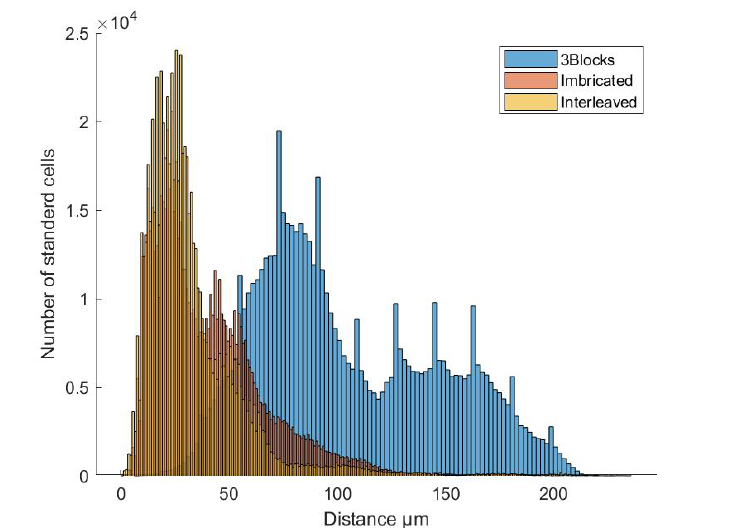
Figure 6. TMR branch logic spacing for the 8 × 16 bit design post-Clock Tree Synthesis (CTS).